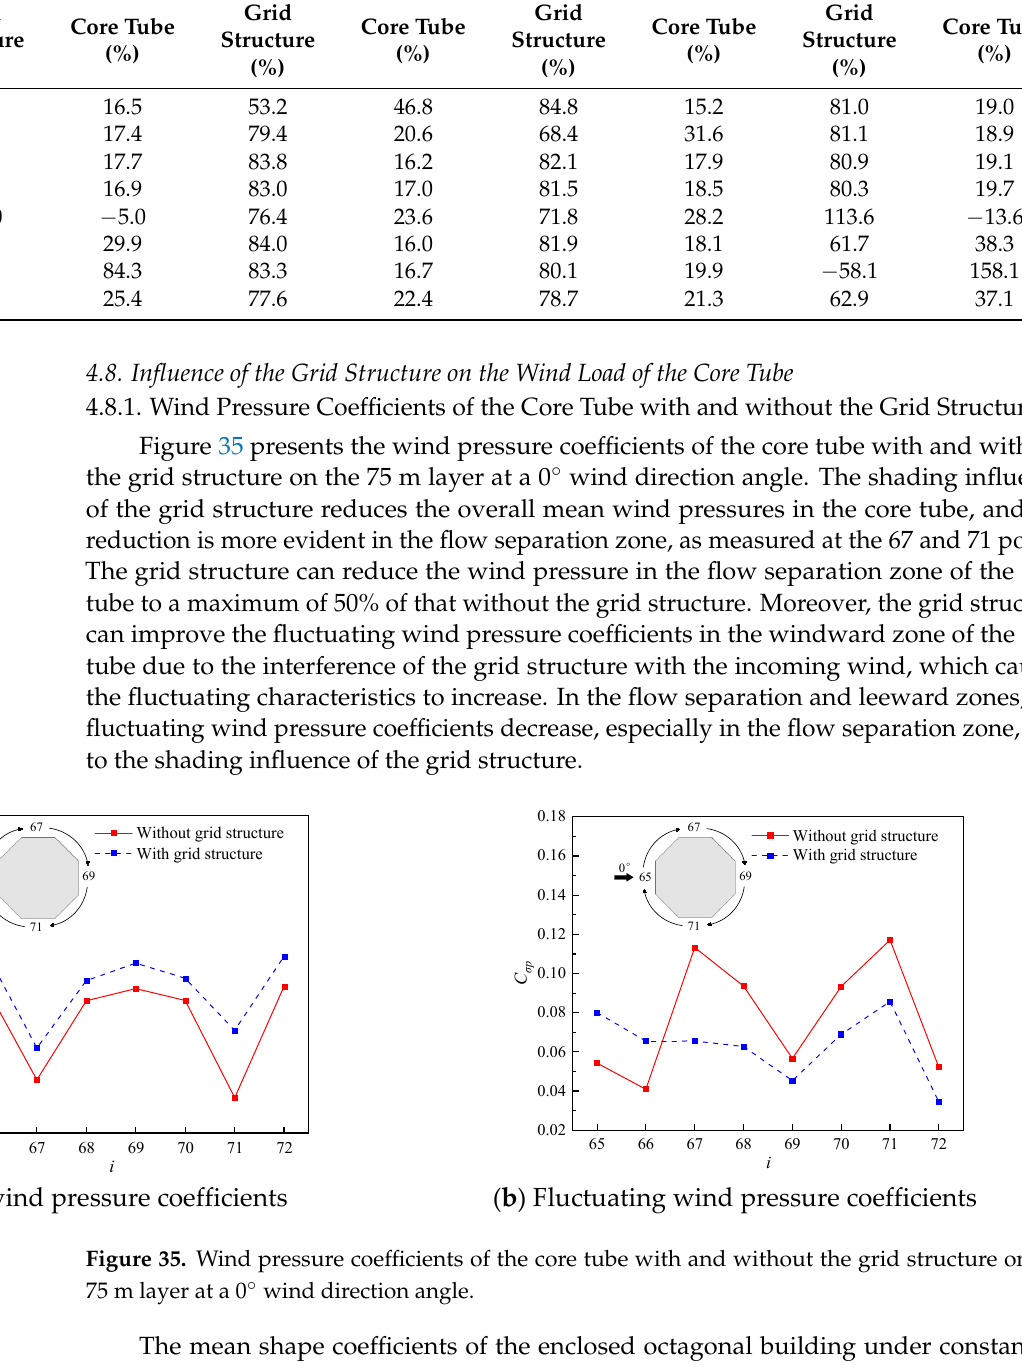
Table 5. Mean shape coefficients of different wind-affected zones at 0°, 45°, and 90° wind direction angles. Measuring Point Number